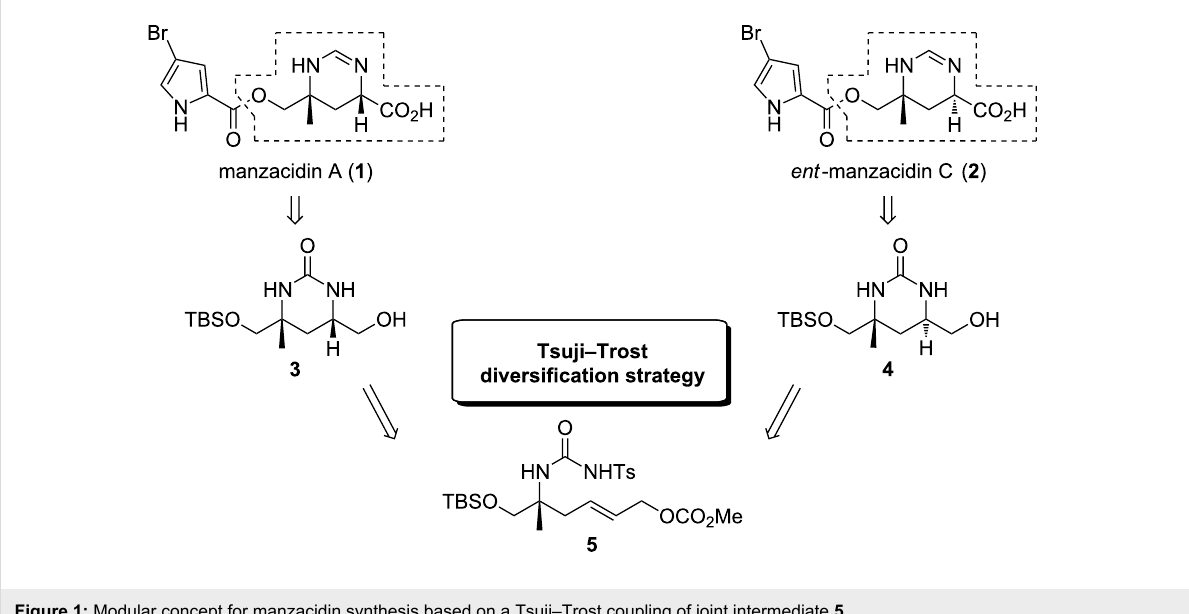
Figure 1: Modular concept for manzacidin synthesis based on a Tsuji–Trost coupling of joint intermediate 5 .